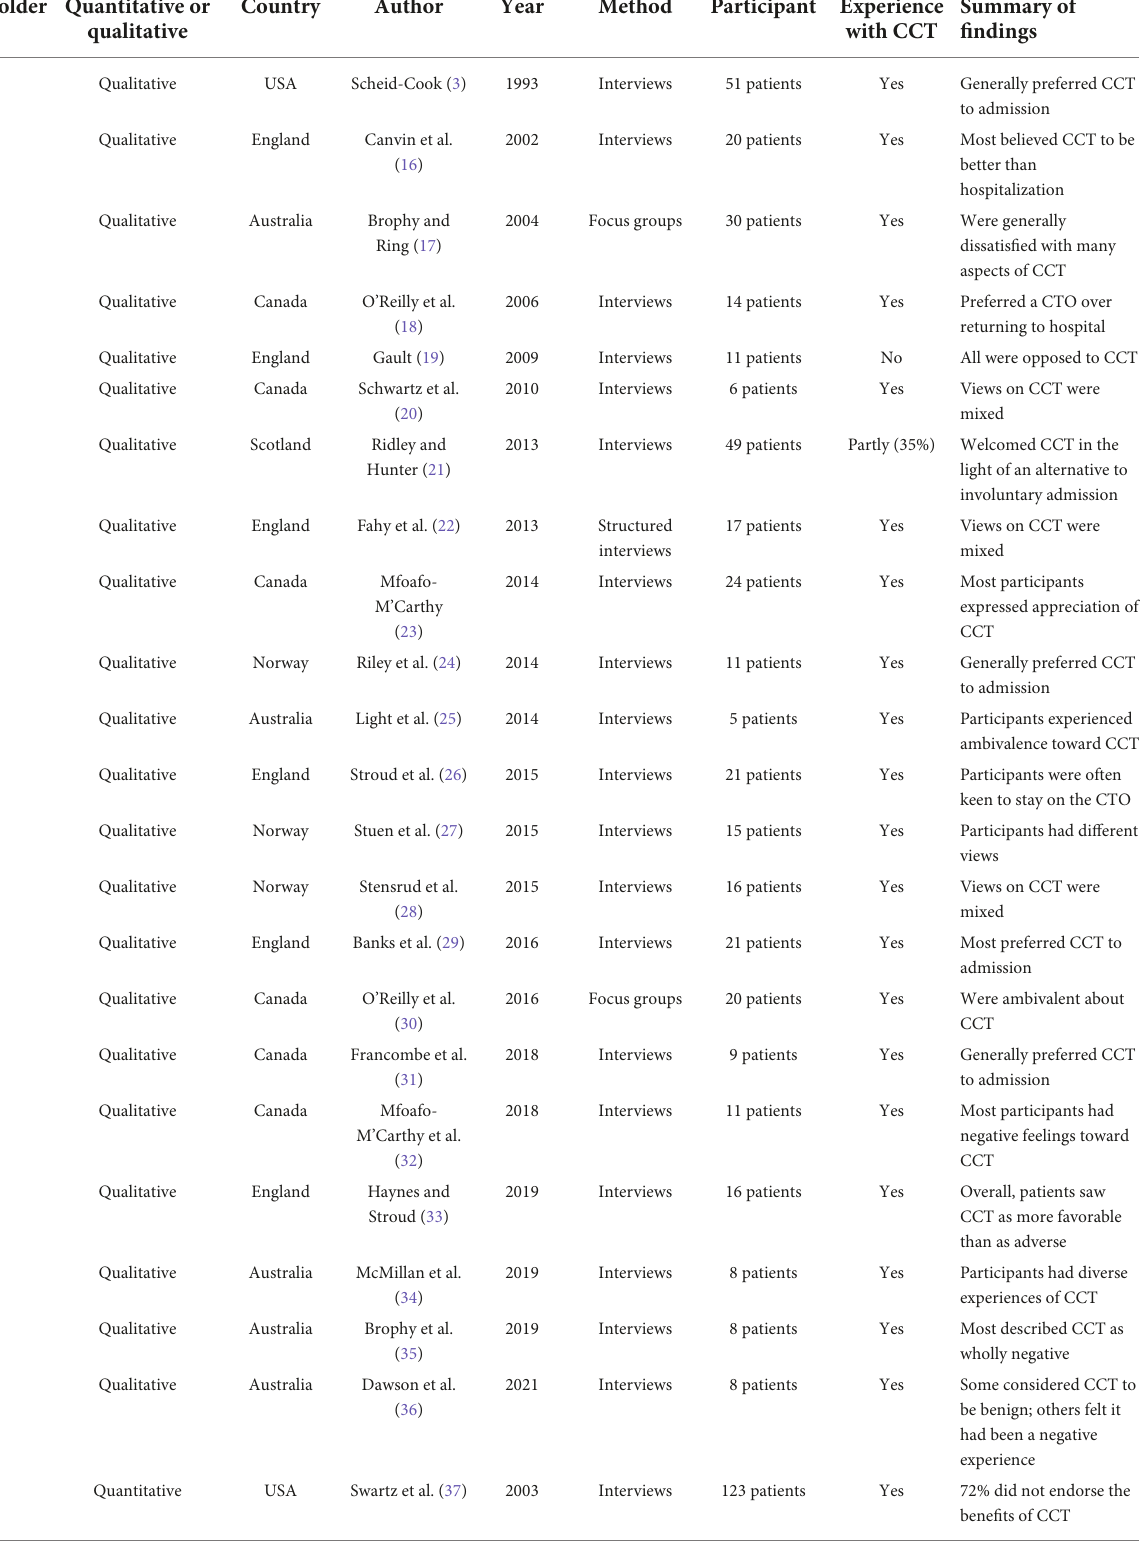
TABLE 2 Outcomes of the studies that investigated the views of patients, significant others and mental health workers on the use of compulsory community treatment (CCT). Stakeholder Quantitative or